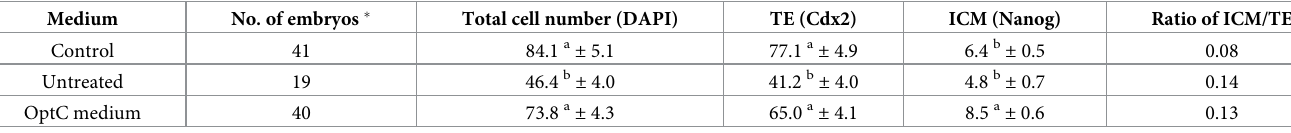
� Embryos were randomly selected from blastocysts derived from the ICR experiment (Table 1). Control: Embryos were cultured on the dish covered with mineral oil. Untreated: Embryos were cultured in a plastic tube using untreated CZB medium. a–b indicate a significant difference (tukey’s test) compared in each number of cells (P <